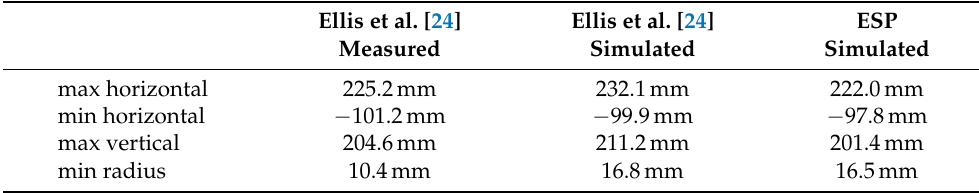
Table 8. Comparison of the results measured and simulated by Ellis et al. [24] and generated using the ESP as